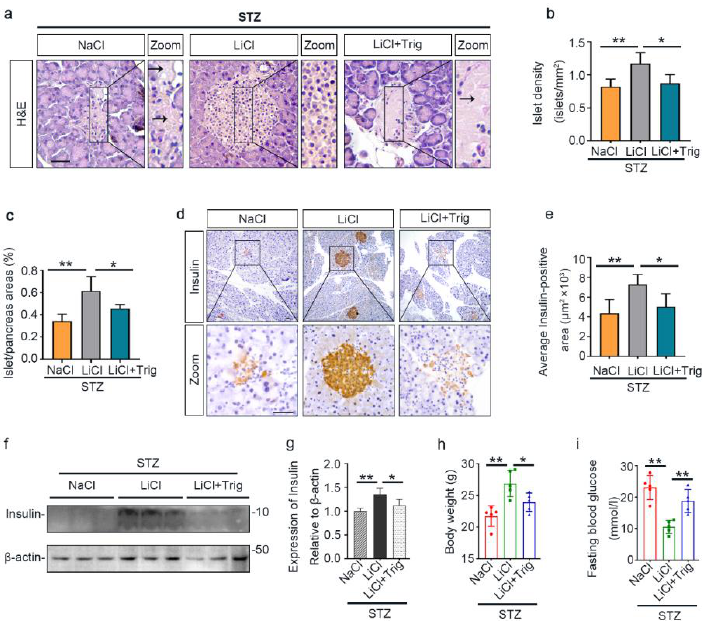
Figure 7. The potentiated Nrf2 activity is essential for the beneficial effect of microdose lithium therapy on islet injury, β -cell destruction and T1D in STZ-injured mice. Animals were treated as elaborated in Figure 5. ( a ) Formalin-fixed, paraffin-embedded pancreas sections were subjected to H&E staining for light microscopy. Representative microscopic images were shown. Islet damages were characterized by diffuse necrosis and were concomitant with β -cells destruction and disappearance (black arrows). Scale bar = 50 µm. ( b ) Islet number relative to pancreas areas and ( c ) islet areas relative to pancreas areas were measured by computerized morphometric analysis based on H&E staining of pancreatic sections. Data were presented as mean ± SD; * p < 0.05, ** p < 0.01 ( n = 5). ( d ) Formalin-fixed, paraffin-embedded pancreas sections were prepared for peroxidase immunohistochemistry staining for insulin to demonstrate the protective effect of lithium on β -cells destruction, which was abolished by Trig treatment. Scale bar = 50 µm. ( e ) Average insulin-positive areas were measured by computerized morphometric analysis based on pancreatic sections stained for insulin. Data were presented as mean ± SD; * p < 0.05, ** p < 0.01 ( n = 5). ( f ) Isolated pancreatic islets were subjected to immunoblot analysis for insulin and β-actin, respectively. ( g ) The abundance of insulin in pancreatic islets was determined by densitometric analysis of immunoblots as relative levels normalized to β -actin. Data were expressed as fold changes over the NaCl group and presented as mean ± SD; * p < 0.05, ** p < 0.01 ( n = 5). ( h ) Body weights and ( i ) fasting blood glucose levels were measured on day 12. Data were presented as mean ± SD. * p < 0.05, ** p < 0.01 ( n =